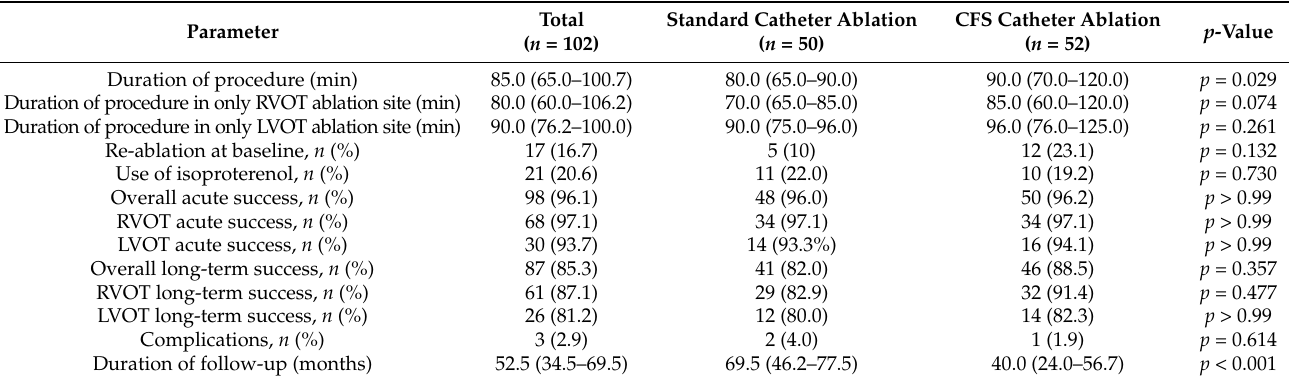
Table 2. Procedural parameters and